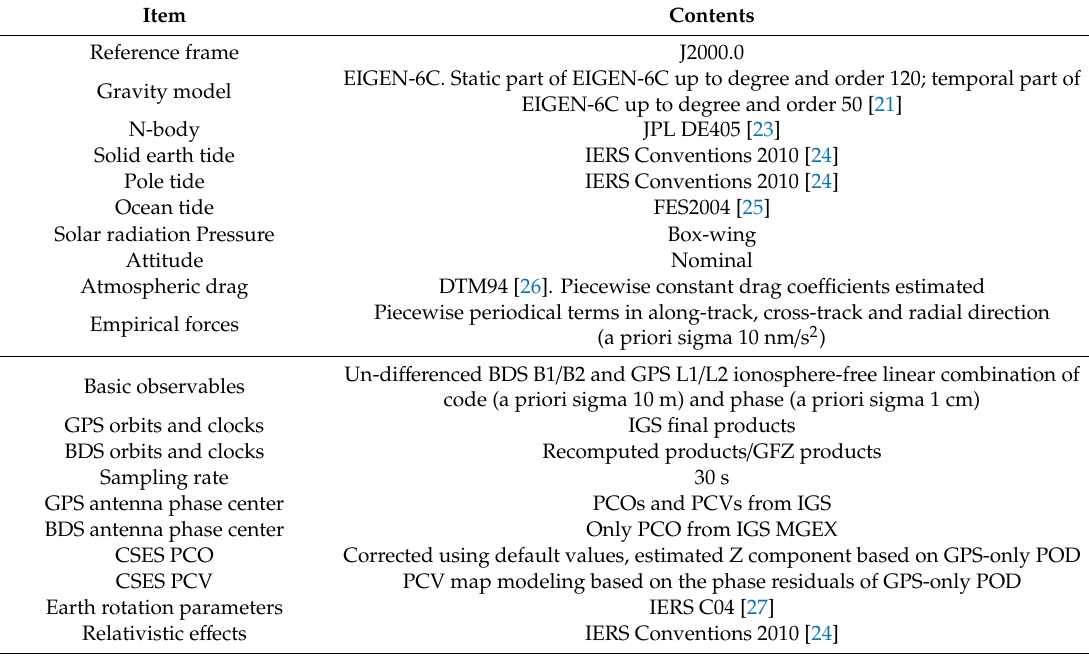
Table 2. Precise orbit determination (POD) strategy for